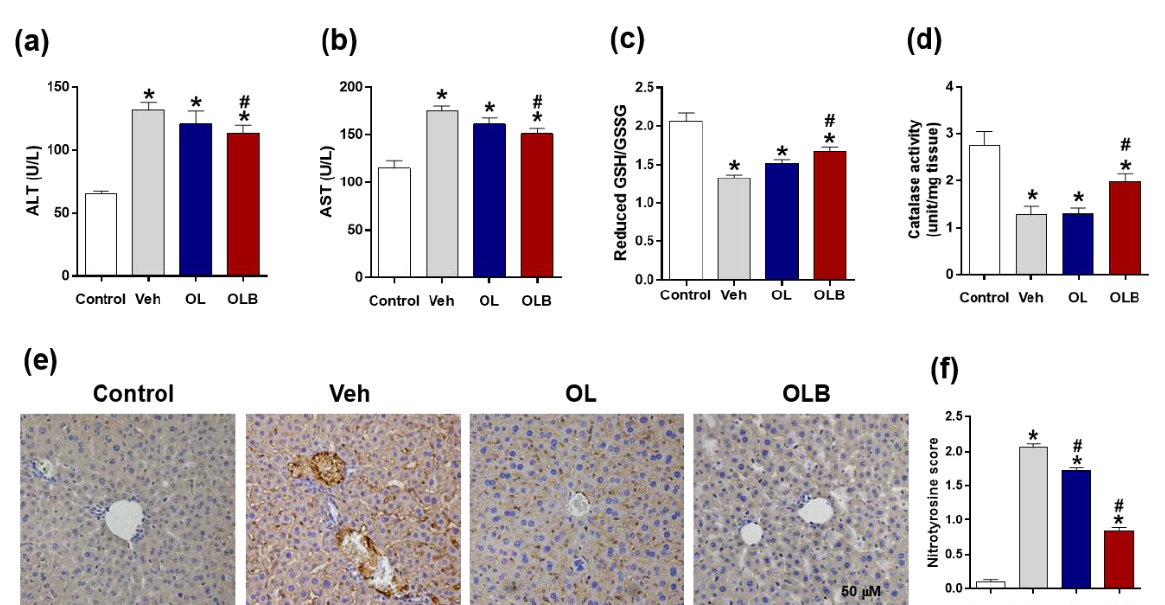
Figure 5. OLB treatment prevents acute ethanol-induced liver damage. Mice were treated with water (Veh), OL, or OLB 1 h before injection of 1.5 g/kg ethanol, and blood and liver tissues were collected 3 h later. As a control group, an untreated treatment group ( n = 5) was included. Blood was collected, and plasma ( a ) ALT and ( b ) AST levels were measured. The ratio of reduced glutathione (GSH) to oxidized glutathione (GSSG) ( c ) and catalase activity ( d ) in mice liver tissue were measured after ethanol injection. Liver sections from each group were processed for representative immunohistochemistry of nitrotyrosine-positive signals, and representative images are shown ( e ). Nitrotyrosine score was measured ( f ). The data are presented as the means ± SEM. * p < 0.05 versus control; # p < 0.05 versus Veh. Scale bar = 50 µm.